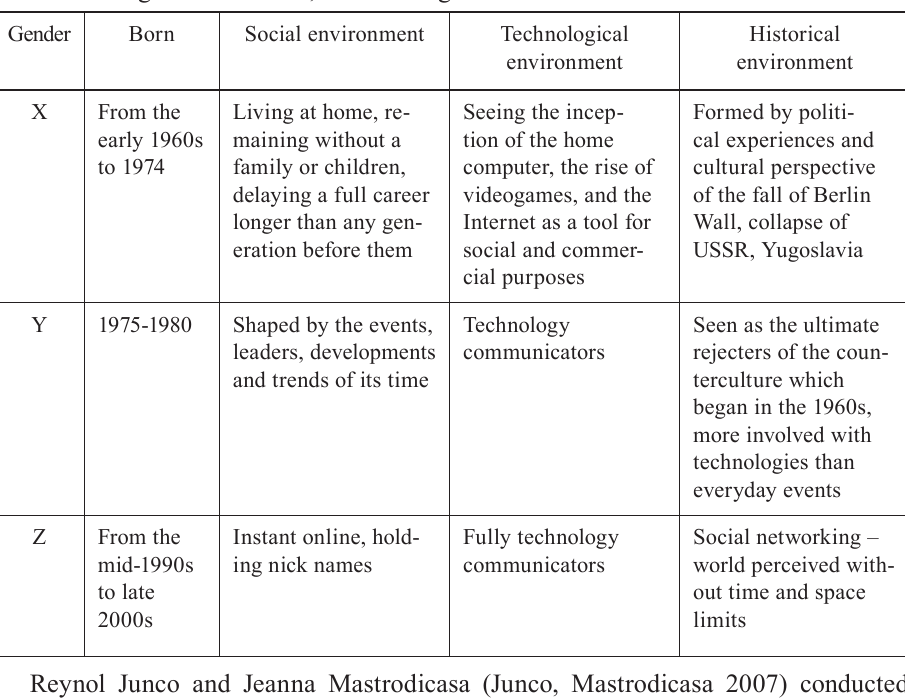
Table 1. Categories of Gen X, Y and Z